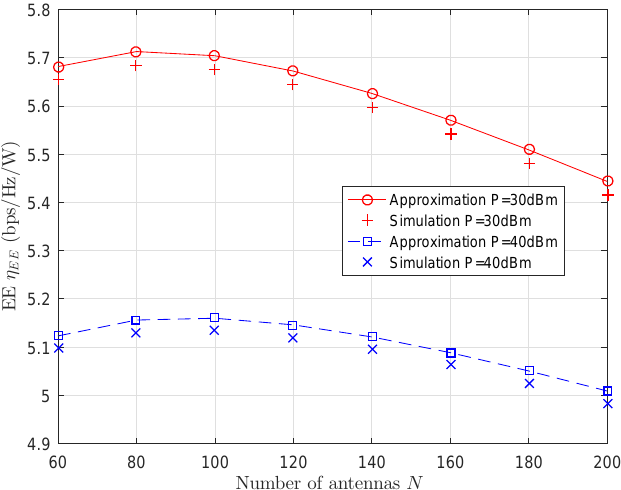
Figure 2. The energy efficiency (EE) versus the number of antennas.